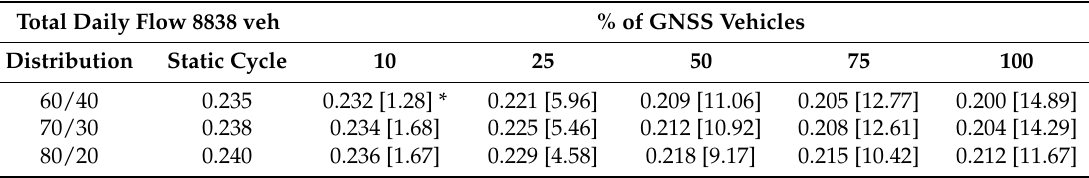
Table 5. Average fuel consumption [l/km], in a typical day, for Case A.